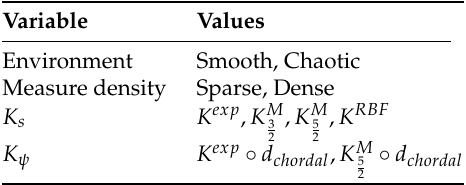
Table 1. Different settings used in our